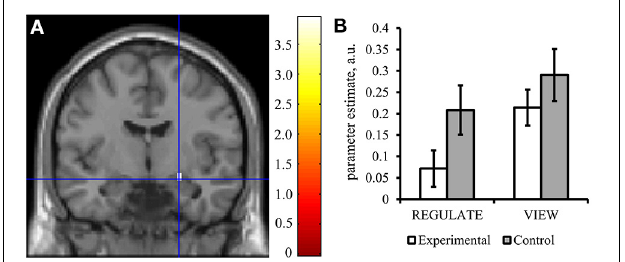
FIGURE 5 | The experimental group down-regulated the right amygdala response in the transfer run. (A) Voxels were found activated at p < 0 . 05 (family-wise error corrected for multiple comparisons) in an anatomical mask of the right amygdala (Tzourio-Mazoyer et al., 2002) for the contrast VIEW > REGULATE in the experimental group. Crosshairs indicate location of the peak voxel at [24, − 7, − 14], Montreal Neurological Institute coordinate space. Activation is displayed on a coronal view of the SPM8 canonical standard template. Left is left. Scale indicates t -values of the parameter estimate. (B) Mean parameter estimate of all voxels within the right amygdala mask of the REGULATE > NEUTRAL and VIEW > NEUTRAL contrast, taken from the transfer run. White bars: experimental group ( N = 16), gray bars: control group ( N = 16). Error bars indicate standard error of mean. A.u., artificial units.